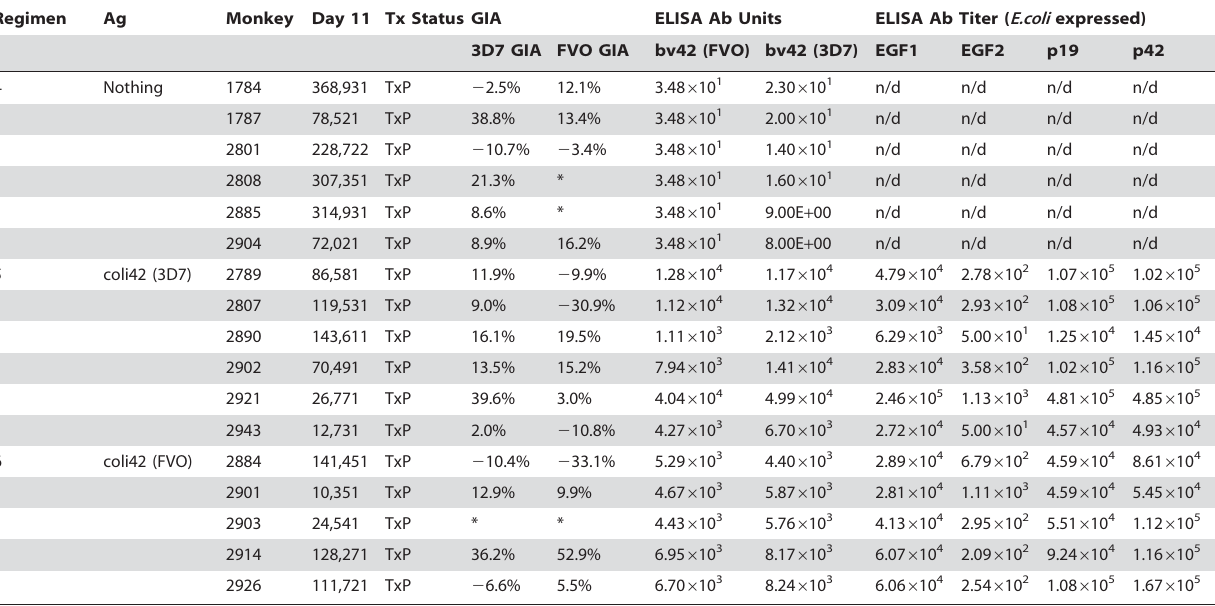
Regimen Ag Monkey Day 11 Tx Status GIA ELISA Ab Units ELISA Ab Titer ( E.coli expressed)